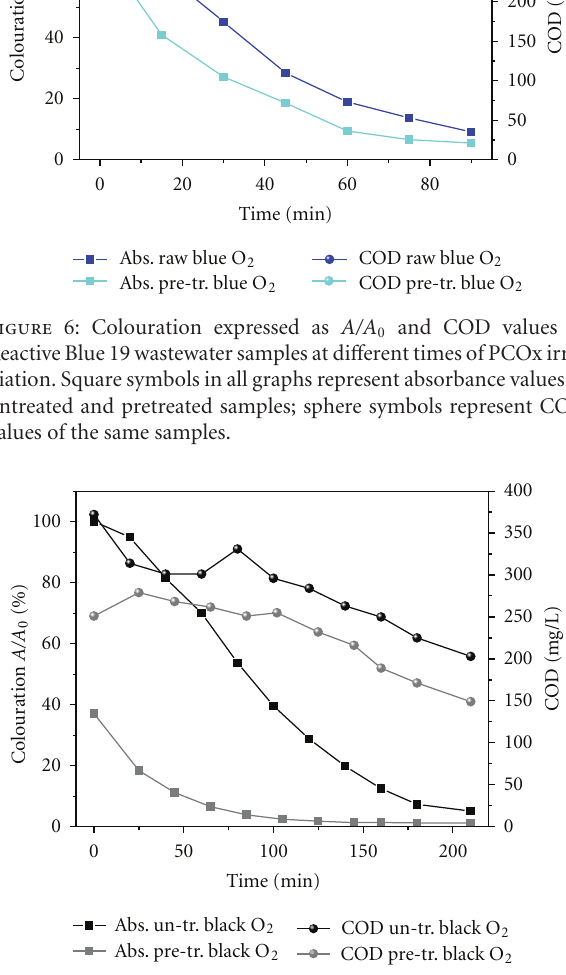
Figure 7: Colouration expressed as A/A 0 and COD values of Reactive Black 5 wastewater samples at di ff erent times of PCOx irra- diation.